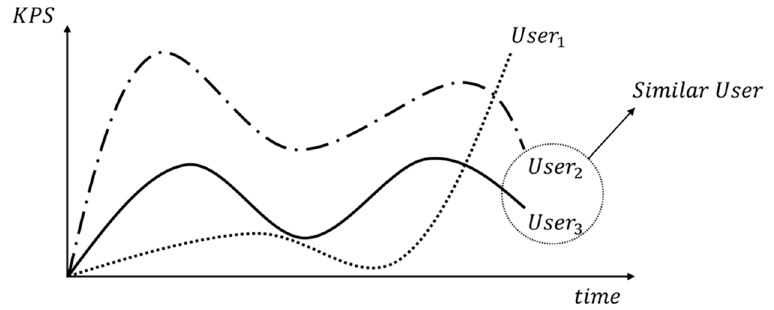
Figure 7. Searching similar